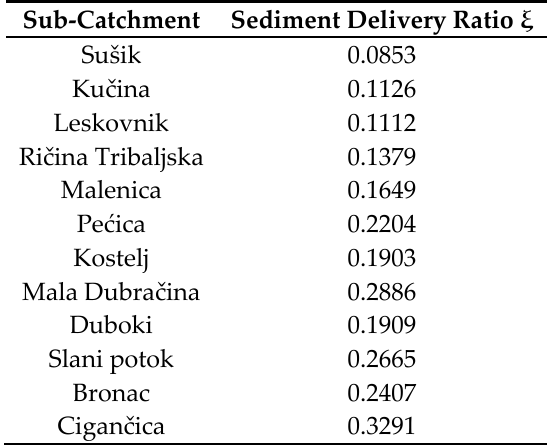
Figure 3. Sediment delivery ratio for the third case scenario. Table 4. Sediment delivery ratio for the second case